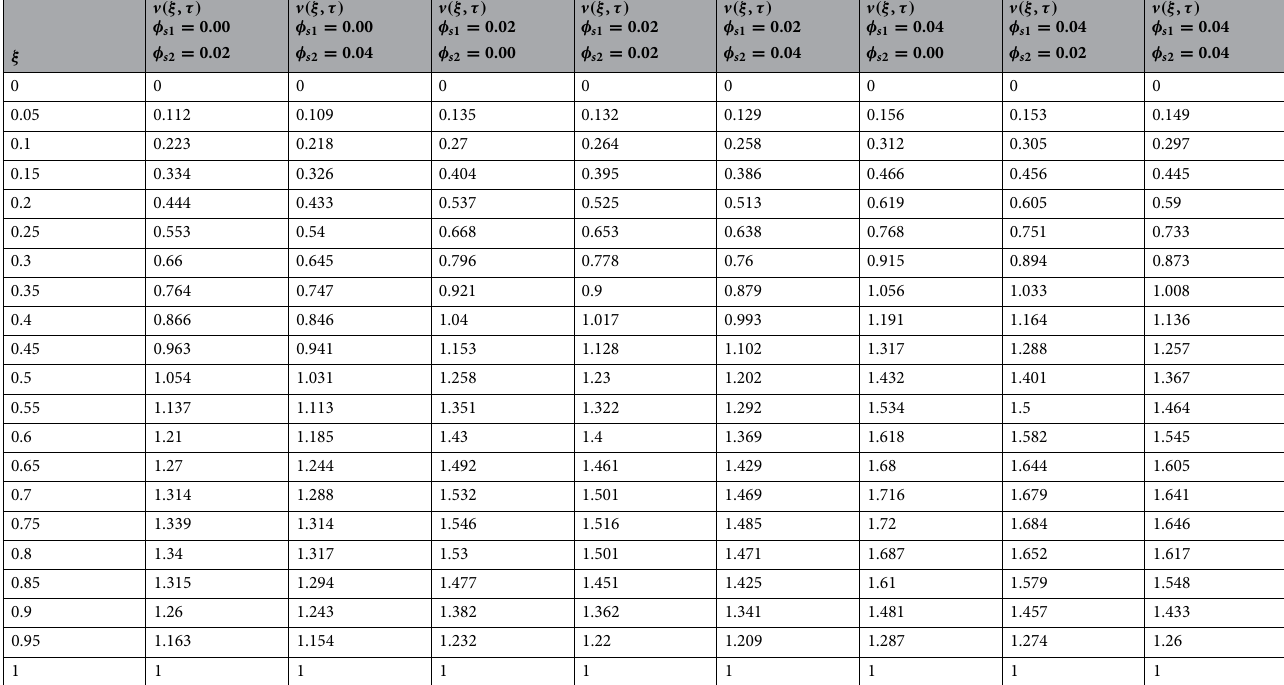
Table 5. The influence of various values of volume fractions of nanoparticles on the velocity profile.